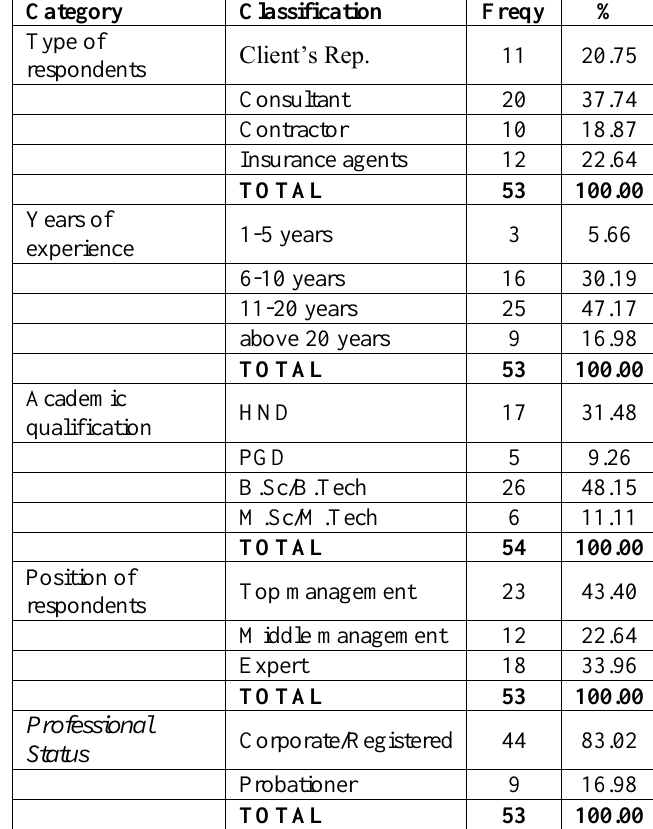
Table 2: Profile of the Respondents Involved in the